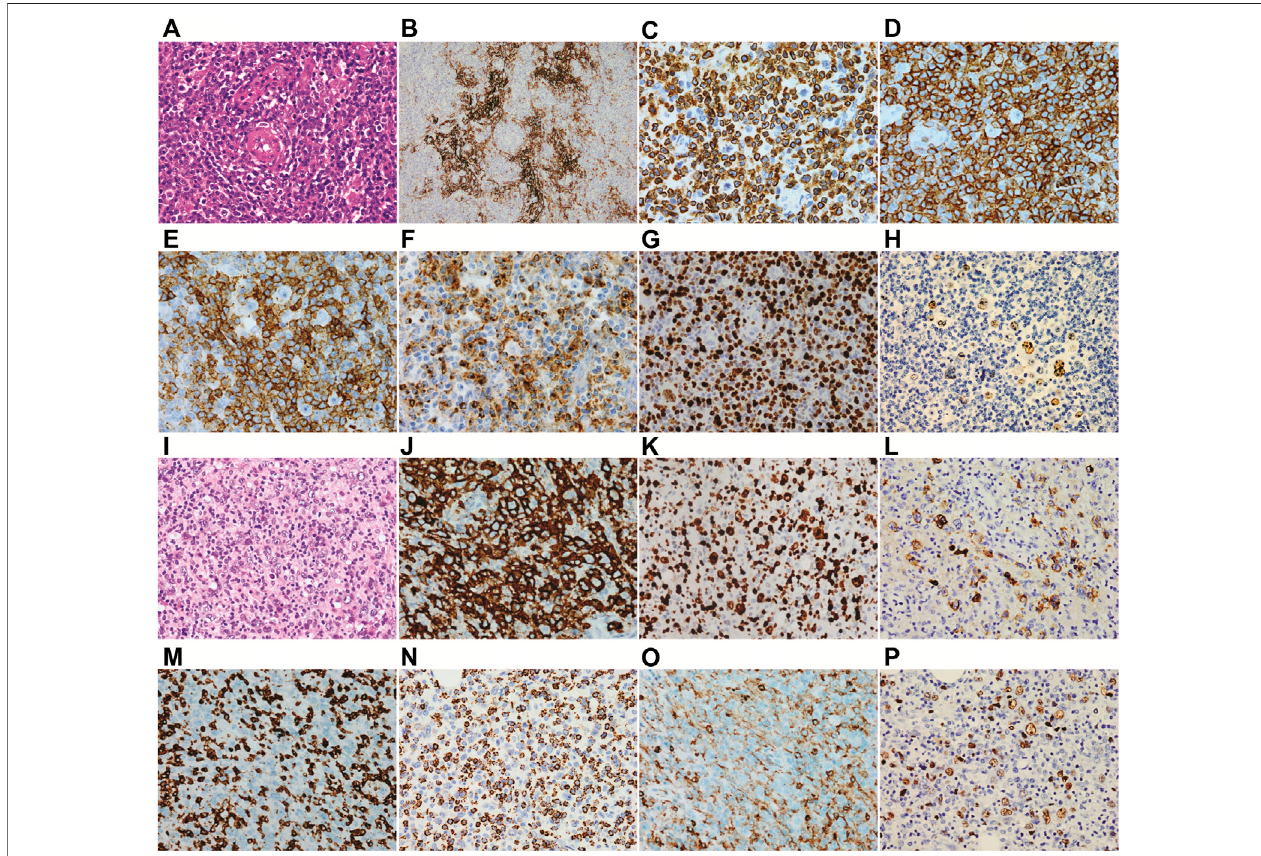
FIGURE2| Histopathology ofbiopsy. (A – H) the fi rst biopsyoftheright inguinal lymphnode which isdiagnosed asangioimmunoblasticT-cell lymphoma and (I – P) the second biopsy of the right neck lymph node which is diagnosed as Epstein – Barr virus + diffuse large B-cell lymphoma. (A) a large number of diffuse medium-sized atypical lymphocytes proliferated with vascularity was observed. (B) increased extrafollicular follicular dendritic cell meshwork was observed. Immunohistochemical staining demonstrated that the lymphocytes were positive for CD3 (C) , CD4 (D) , PD-1 (E) , and CXCL13 (F) . (G) both the medium-sized T lymphocytes and scattered large B cells were positive for Ki67. (H) B cells were positive for EBER. Abnormal hyperplasia of large cells was observed (I) , and the cells were positive for CD20 (J) ,Ki-67 (K) ,andLMP1 (L) andnegativeforCD3 (M) . (N) thesmalllymphocyteswerepositiveforTIA-1. (O) onlythescatteredsmalllymphocyteswerepositivefor CD4, and the histiocytes were weakly positive for CD4. (P) most of the large B cells were positive for EBER.